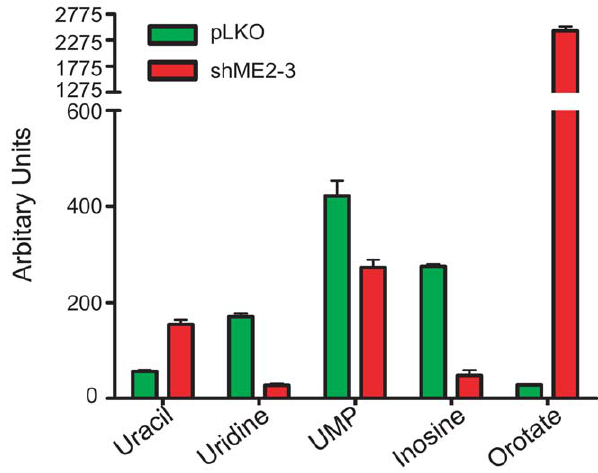
Figure 8. Knockdown of ME2 alters pyrimidine metabolism in K562 cells. The metabolites were measured by LC-MS method as described in ‘‘Materials and Methods’’.